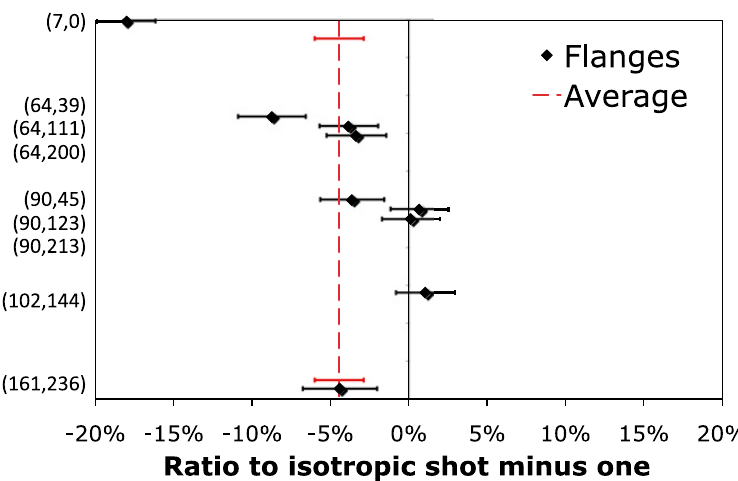
Figure 2. Flange-NAD results (see text) from the N110620-002 layered-cryogenic DT shot, relative to the assumed- isotropic N101030-002 exploding pusher shot. The ordinate is cos( (cid:5) ) with offsets to separate the three datapoints at (cid:5) = 64 ◦ and 90 ◦ . The uncertainty in the average is the statistical uncertainty in the reference foil (well)